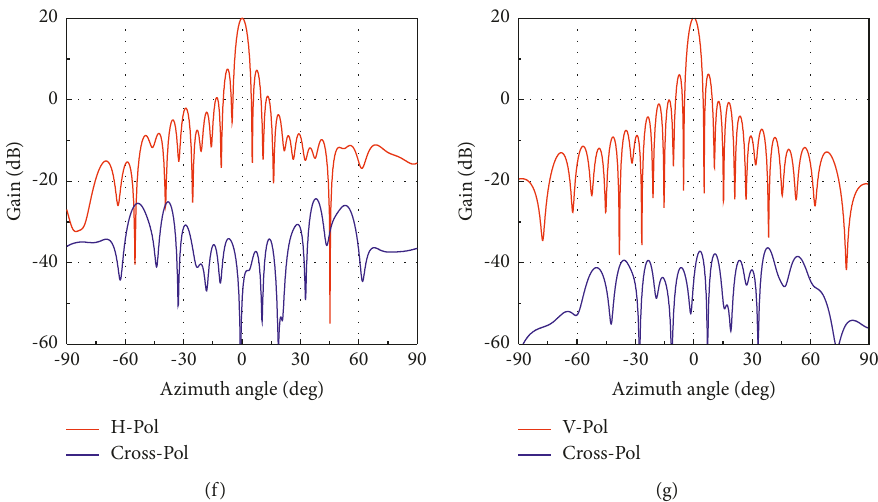
Figure 2: (a) Picture of the waveguide slot antenna subarray. (b) Schematic diagram of the large antenna array. (c) Top view of the antenna subarray. (d) Section view of the antenna subarray. The unit in (c) and (d) is millimeter. (e) The measured VSWR of the dual-polarized antenna. (f) Cross-polarization level of H polarized waveguide antenna. (g) Cross-polarization level of V polarized waveguide